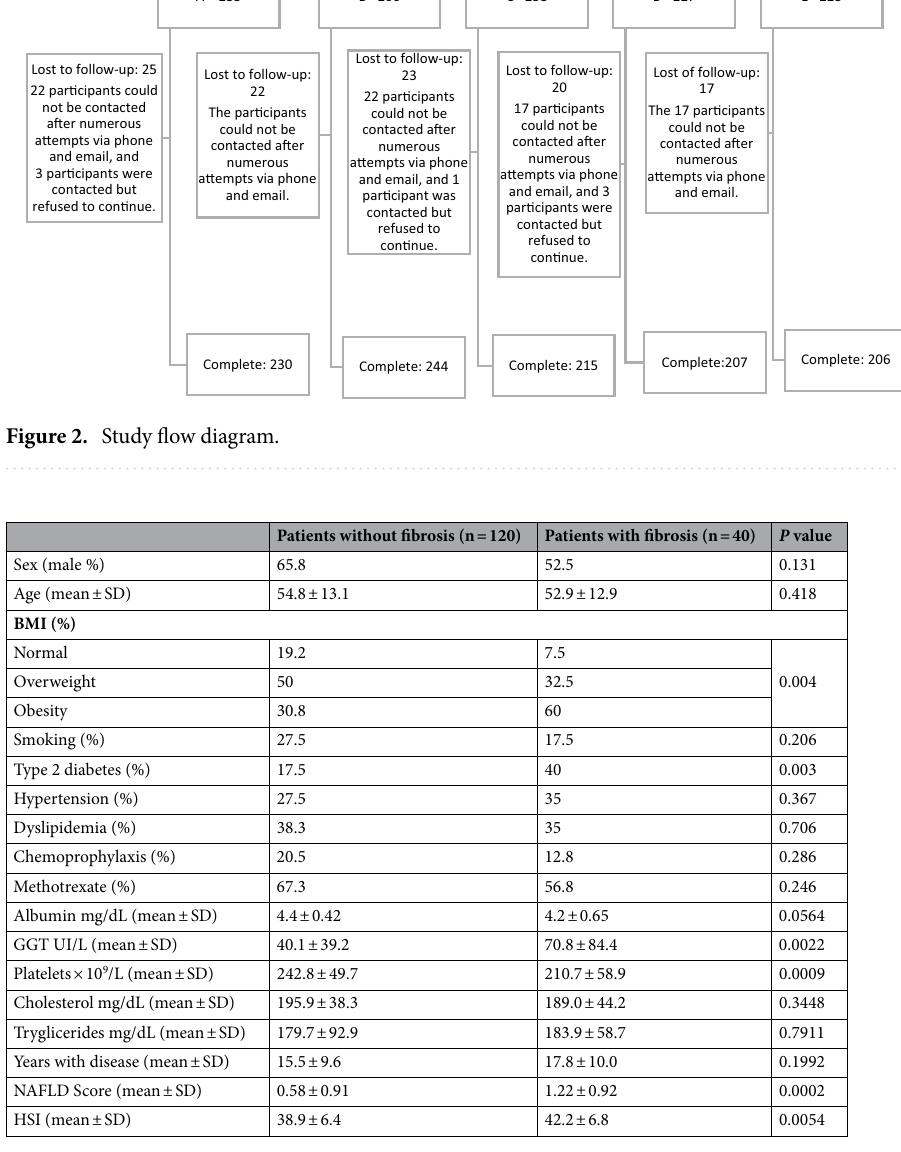
Table 1. Comparison between patients with and without liver fibrosis. *Chi-squares for proportion and t test for means and standard deviations. BMI Body Mass Index, GGT gamma glutamyl transpeptidase, NAFLD non-alcoholic fatty liver disease, HIS Hepatic steatosis index. Fibrosis was considered any of the following: a NAFLD fibrosis score > 0.675 and/or a transient elastography value > 8.7